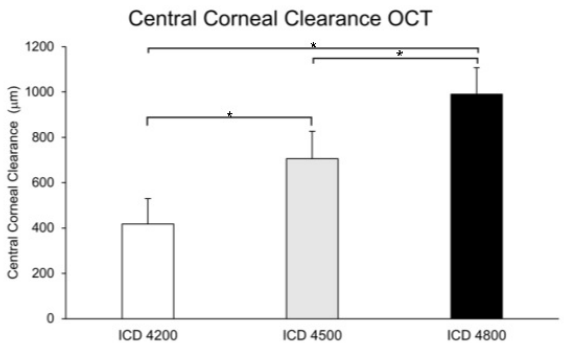
Figure 2. Central corneal clearance with the different scleral contact lenses (ScCL) fitted. Measurement of the corneal clearance with the ScCLs of sagittal heights 4200 µm (white), 4500 µm (grey) and 4800 µm (black). * p < 0.05; Wilcoxon test, Bonferroni test. Error bars represent SD. To evaluate the possible flexure of the three selected ScCLs, a keratometric analysis over the anterior surface of the ScCLs fitted was performed. The magnitude of the astig- matism was higher with the ScCL ICD 4500 compared to the mean values obtained with ICD 4200 and with ICD 4800 (Table 2). Differences were statistically significant ( p = 0.047),